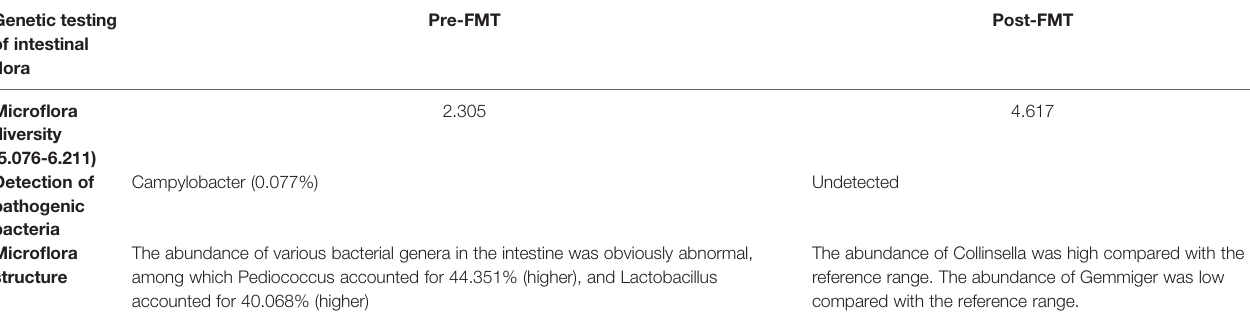
TABLE 2 | Genetic testing of intestinal fl ora prior to and following FMT. Genetic testing of